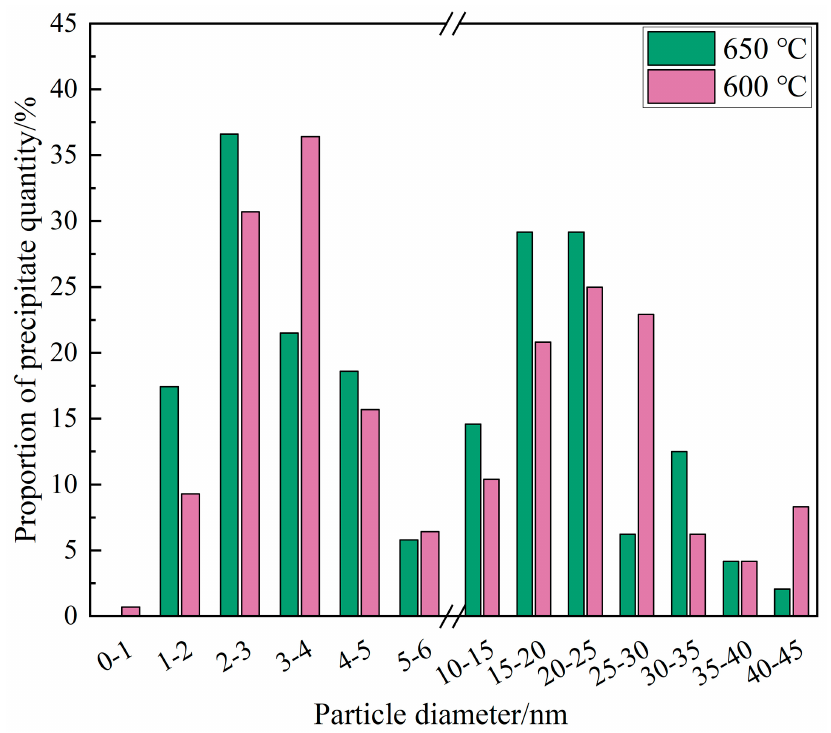
Figure 9. Size distribution of the second-phase precipitation in test steel at different coiling temperatures.